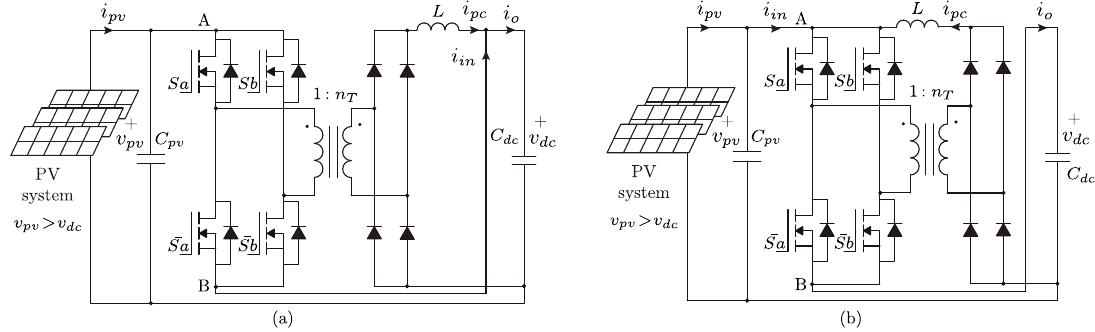
Figure 6. Full-bridge isolated dc–dc topology for the proposed: ( a ) Step-down PPC connected at dc-link side; ( b ) Step-down PPC connected at